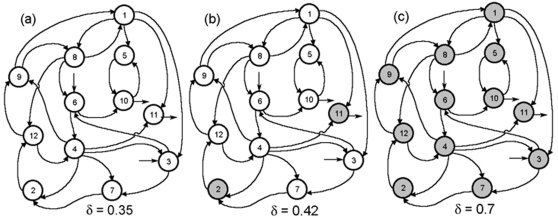
Global configurations in dissipative metabolic networks.In the DMN three kinds of global configurations may emerge. (a) All the subsystems exhibit an on-off changeable state, the δ threshold value parameter (the level of the covalent regulatory activity) is δ = 0.35. (b) A set of metabolic subsystems are locked into an active state (the MSb2 and the MSb11) while the rest of metabolic subsystems exhibit an on-off changeable state, for δ = 0.42. (c) The modification of the δ control parameter leads to a new global configuration of the network in which all the subsystems are in an on state, δ = 0.7. Arrows show substrate fluxes, the subsystems locked always in an active state are shown by dark circles and the metabolic subsystem that always present cycles of activity-inactivity are represented by white circles.